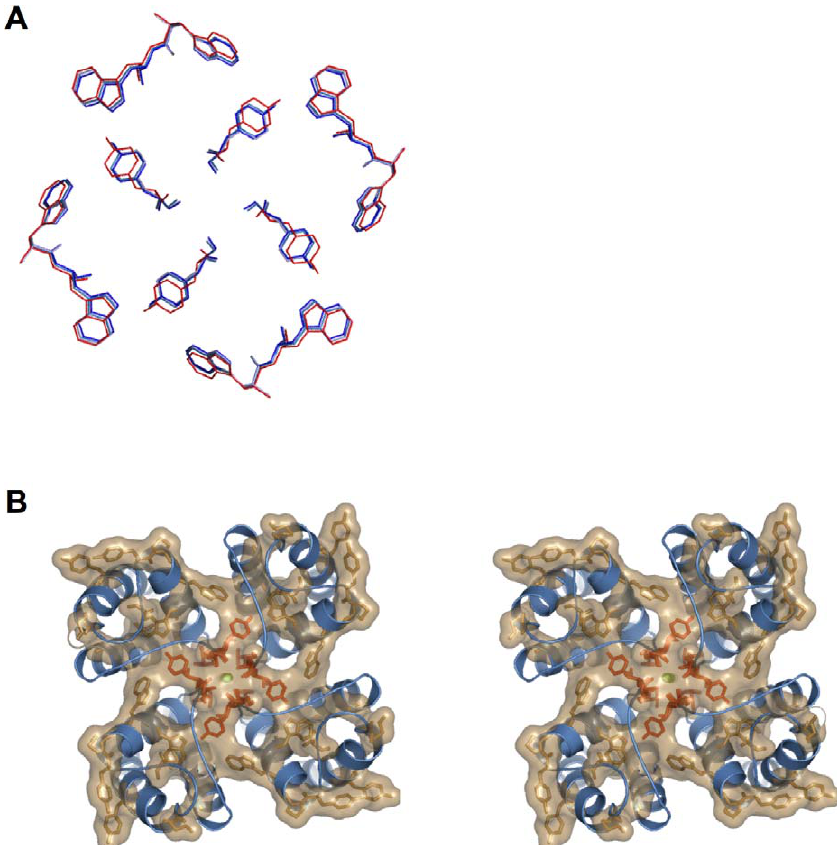
Figure 4. Propagated Residue Displacements Correlate with Ion Binding and Co-Evolving Positions (A) A comparison of the collapsed and conductive conformations of KcsA is shown. The collapsed Na þ -bound structure is shown in red, whereas the conductive K þ -, Rb þ -, or Cs þ - bound structures are shown in various shades of blue. This image is a slice through the S2 ion-binding site as viewed from the extracellular side of the membrane looking down the pore. (B) A stereo-view of the highly conserved selectivity filter (orange) and conserved plus co-evolving (yellow) positions of K þ channels is shown as a stick representation mapped onto the ribbon representation (blue) of KcsA. The brown surface envelops the conserved and co-evolving positions. This view is from the extracellular side of the membrane looking down the pore.